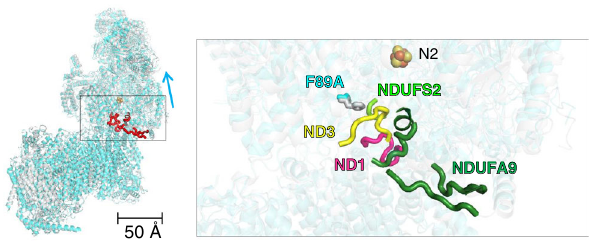
Fig. 2 Weak or missing density in cryo-EM map indicates disorder at the interface of membrane and matrix arm of inactive mutant F89A LYRM6 . Superimposed models of F89A LYRM6 mutant (cyan) and WT complex I from Y. lipolytica (PDB 6RFR, gray) (superimposed at the central section of the membrane arm (subunit ND4); Fe-S cluster N2 is shown in sphere representation). Structural elements showing disorder in mutant F89A LYRM6 are highlighted in red. Inset, residues at position 89 LYRM6 of subunit LYRM6 are shown in stick representation for WT and mutant. Structural elements of subunits ND1 (hot pink), ND3 (yellow), NDUFS2 (green) and accessory NDUFA9 (forest) showing disorder in mutant F89A LYRM6 are displayed in cartoon representation (density maps are shown in Supplementary Fig. 5). The arrow indicates tilting of the peripheral arm in the mutant (Supplementary Fig.